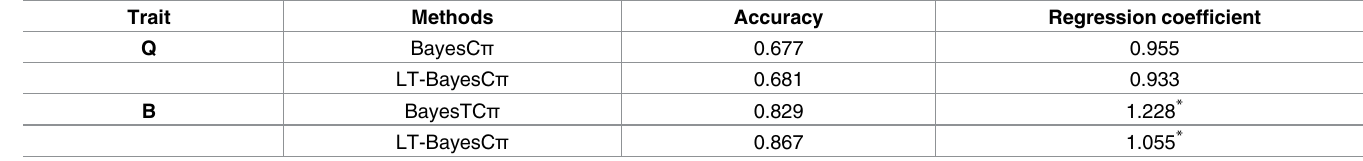
Table 5. Accuracies and bias of GEBVs from three methods for the common dataset from the 14 th QTL-MAS workshop.